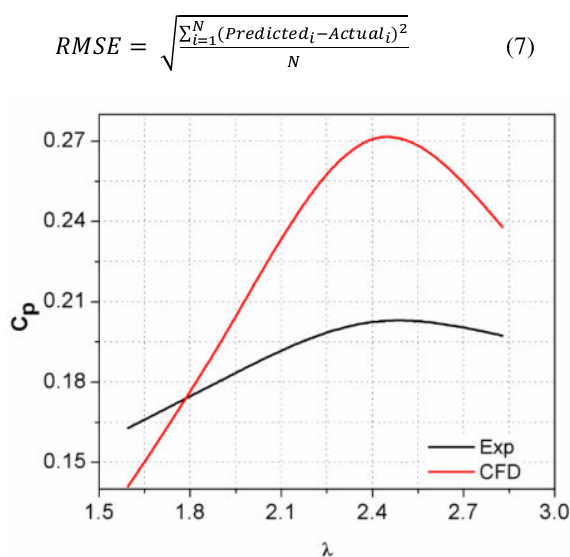
Figure 6. Validation of CFD results with established experimental results [21].